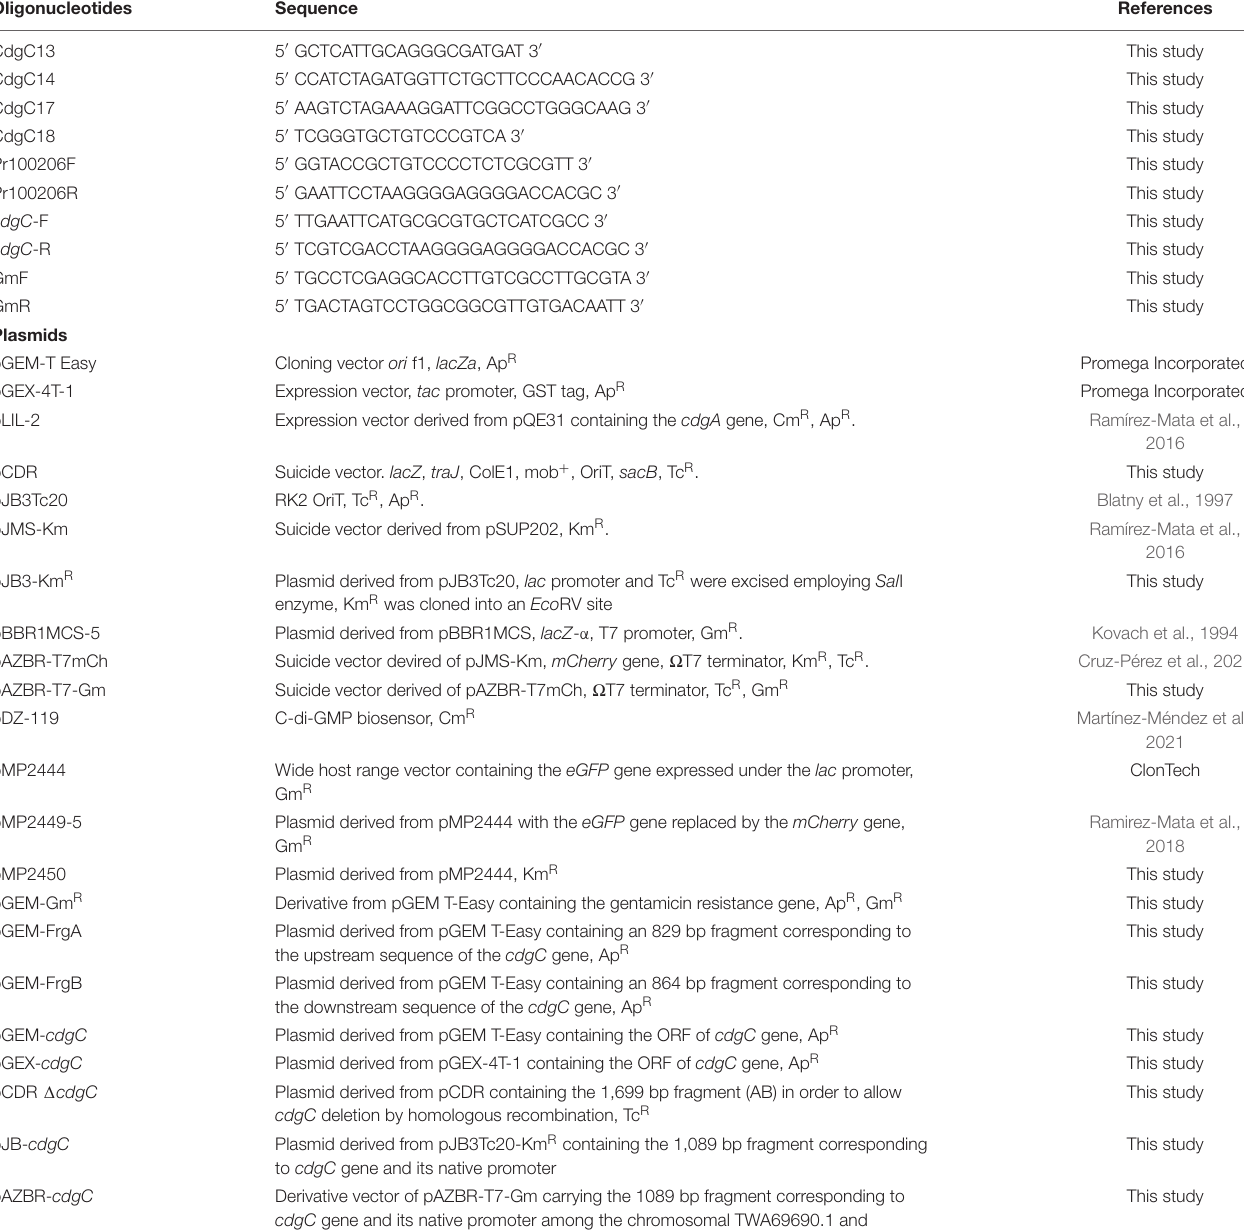
TABLE 2 | Oligonucleotides and plasmids used in this study. Oligonucleotides